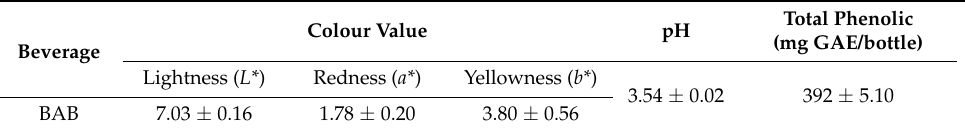
Table 3. The physico-chemical properties of the beverage containing the aqueous extract of banana inflorescence